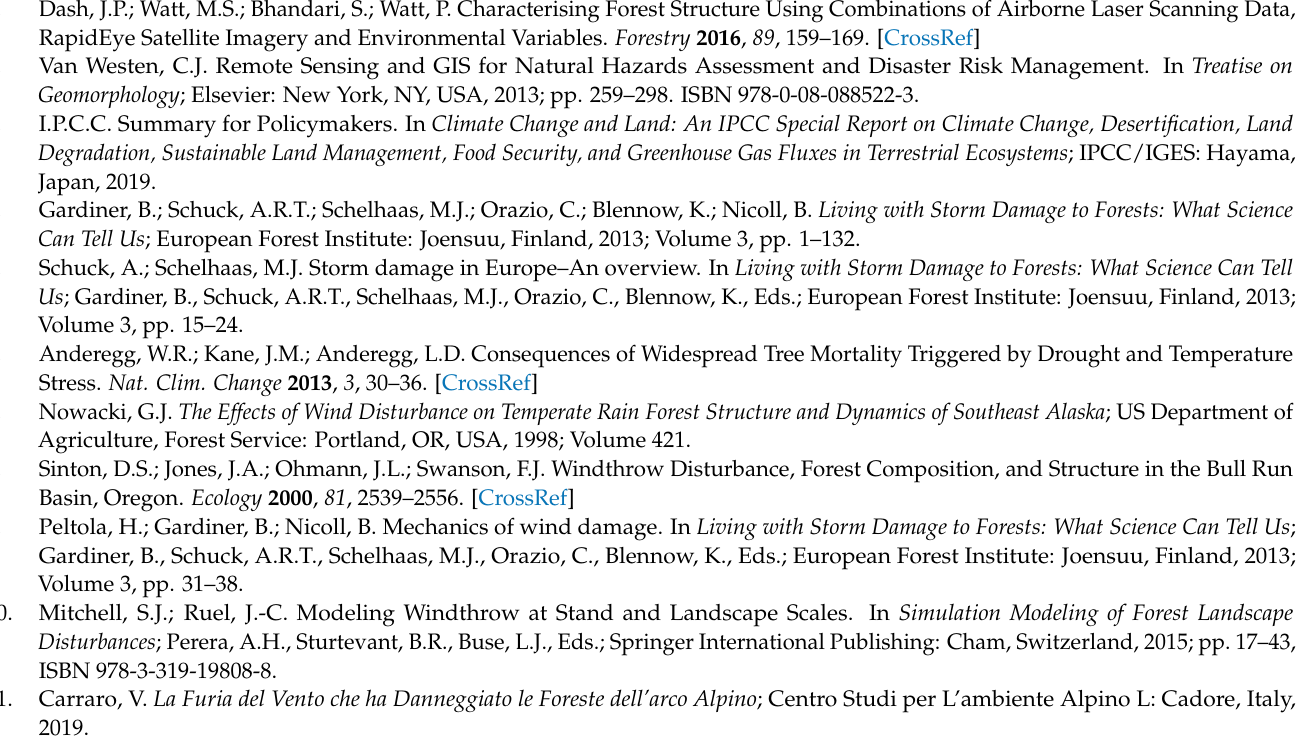
SLAVI, Figure S4: GNDVI, Figure S5: IRECI, Figure S6: NDREDI, Figure S7: Field survey areas, Table S1: Outputs of Generalized Least Square models for indices, Table S2: Outputs of Generalized Least Square models for Sentienl-2 bands, Table S3: Comparison of NDWI8A VID and RFS estimations for